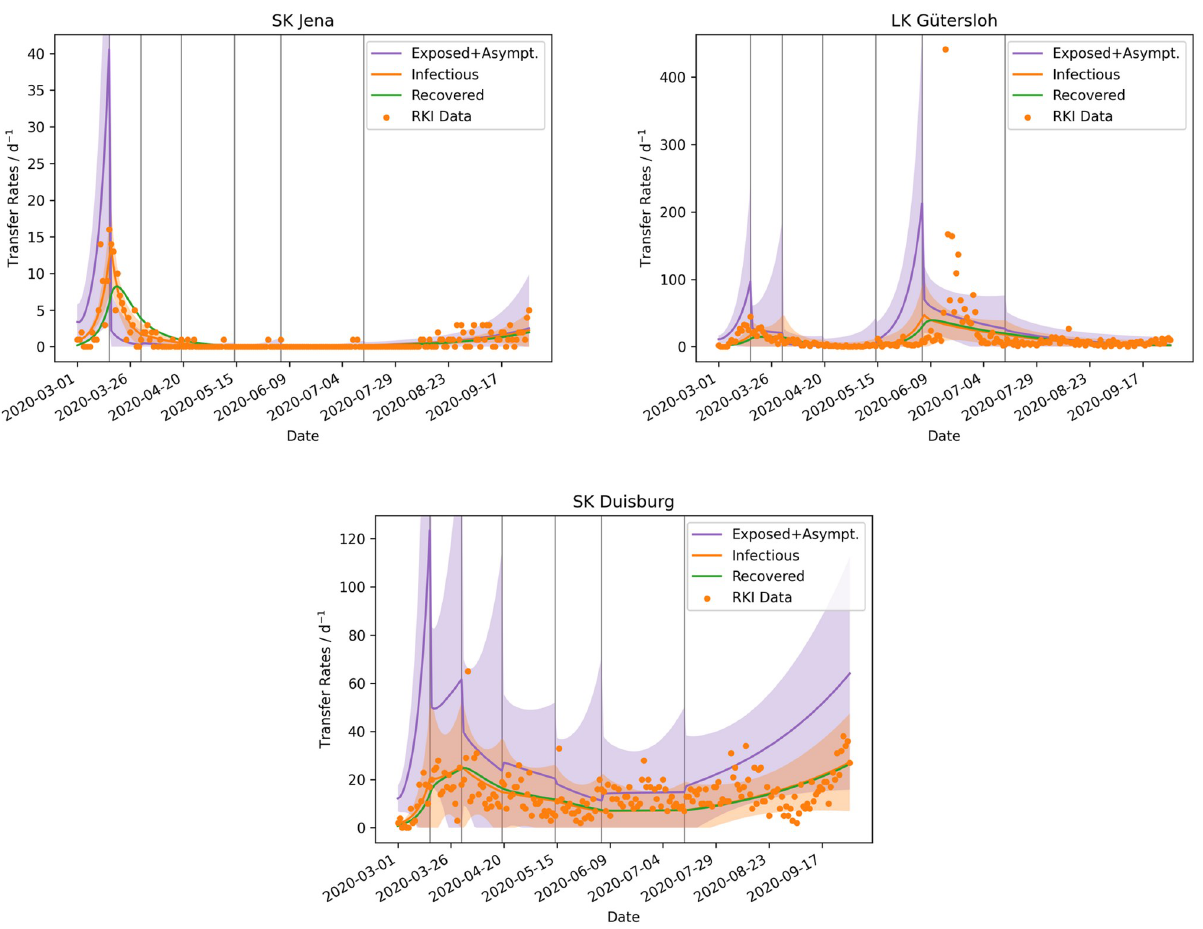
� � is shown in purple, into IS N